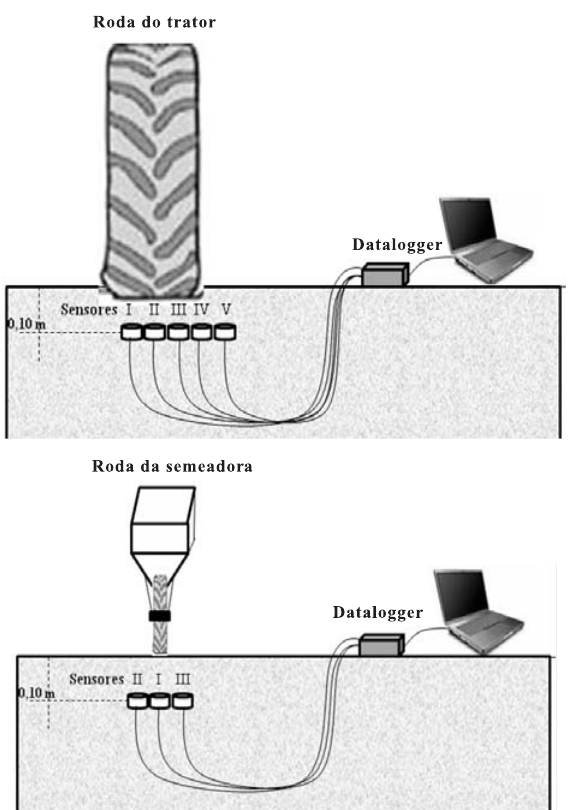
Figura 1. Ilustração do posicionamento dos sensores instalados no solo sob a roda do trator e da semeadora e da coleta dos